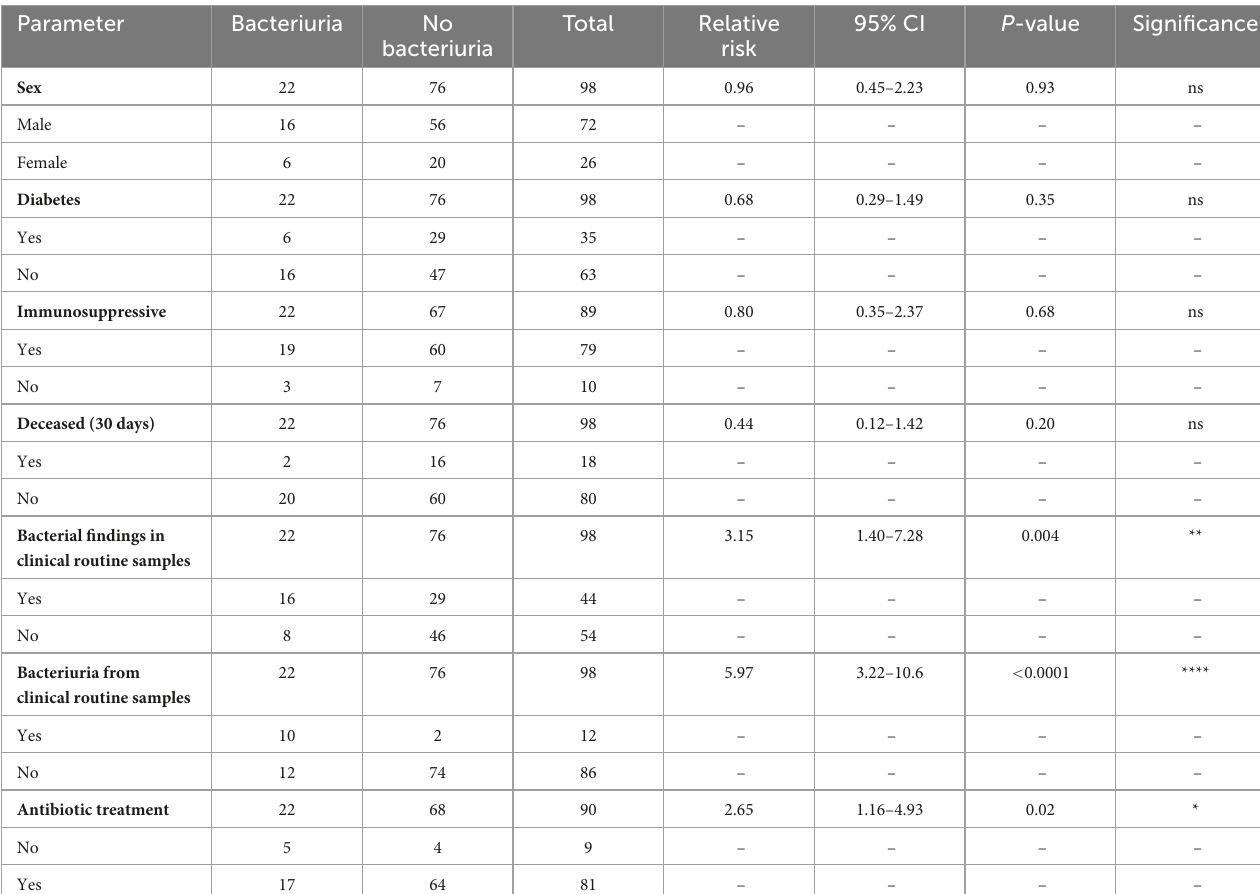
TABLE 1 Characteristics of enrolled coronavirus disease 2019 (COVID-19) intensive care unit (ICU) patients. Parameter